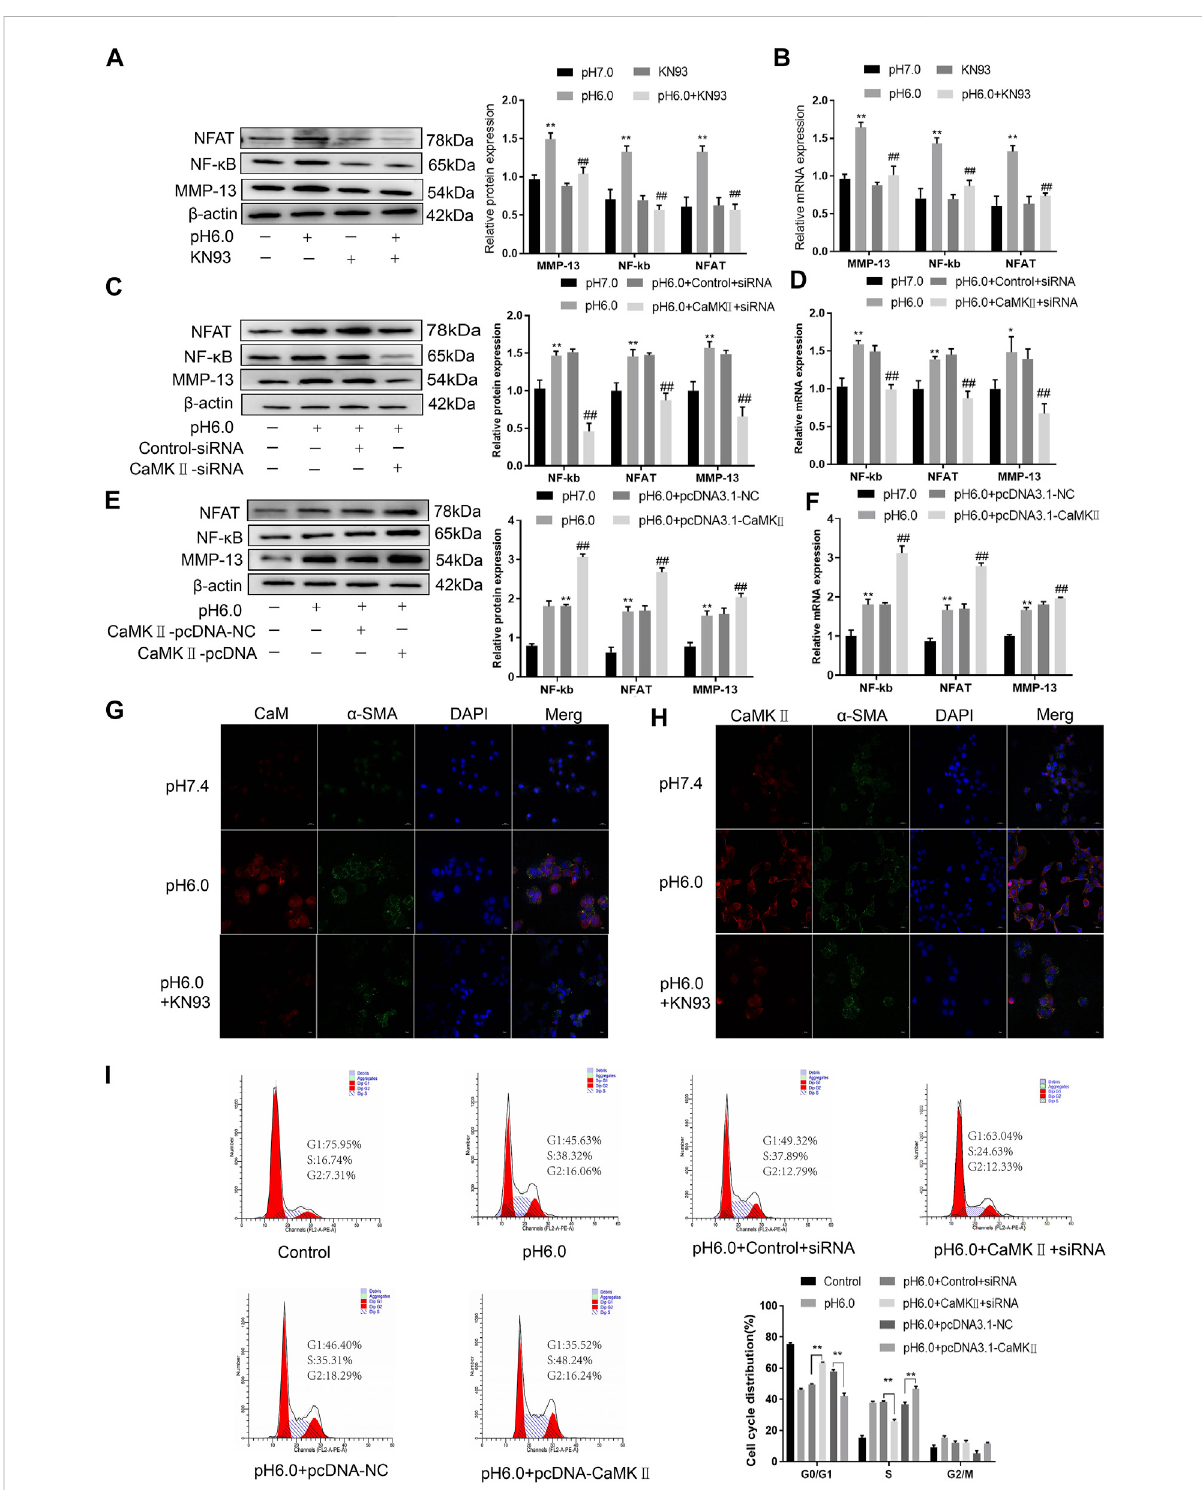
CaM/CaMK Ⅱ promoted the activation and proliferation of HSC. (A) Western blotting analysis and densitometric quanti fi cation of MMP-13, NF- kB and NFAT levels in HSCs under KN93. (B) mRNA levels of MMP-13, NF-kB and NFAT in HSCs treated with KN93. (C) Expression of MMP-13, NF-kB and NFAT in HSCs after transfection of CaMK Ⅱ – siRNA. (D) mRNA levels of MMP-13, NF-kB and NFAT in HSCs after transfection of CaMK Ⅱ -siRNA. (E) Expression of MMP-13, NF-kB and NFAT in HSCs after overexpression of CaMK Ⅱ . (F) mRNA levels of MMP-13, NF-kB and NFAT in HSCs after overexpression of CaMK Ⅱ . (G,H) The expression of CaM/CaMK Ⅱ and α -SMA was detected by immuno fl uorescence. (Scale Bar, 20 μ M). (I) Flow cytometrywasusedtodetecttheeffectofCaMK Ⅱ silencingoroverexpressiononthecellcycleofHSC-T6cells.Dataareexpressedasthemean±SD ( n ≥ 3). * p < .05, ** p < .01 vs. Control group; # p < .05, ## p < .01 vs. pH 6.0